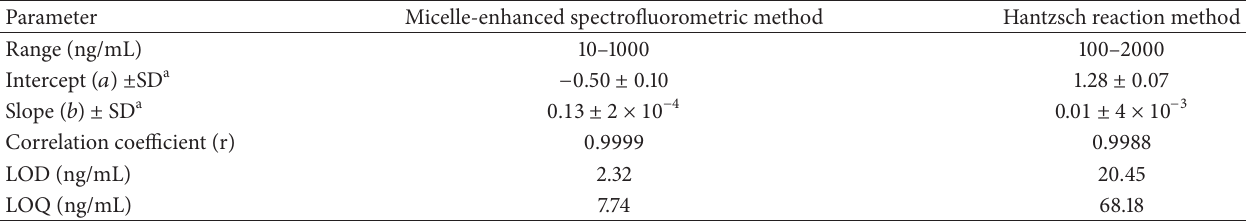
Table 1: Analytical parameters for the determination of GFX using the two proposed methods.